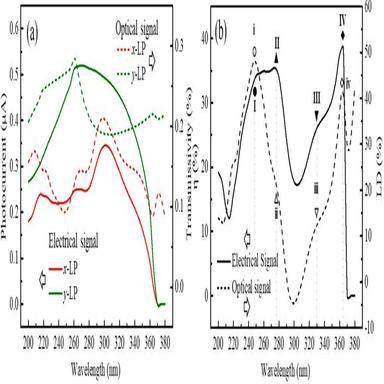
(a) The electrical photocurrent (solid line) and optical transmissivity (dotted line) of MGPIN under x-LP and y-LP, (b) the electrical anisotropy η (solid line) and optical anisotropy LD.